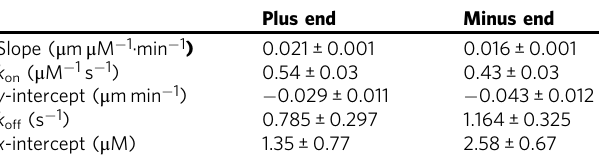
Table 1 Rate constants for axonemal